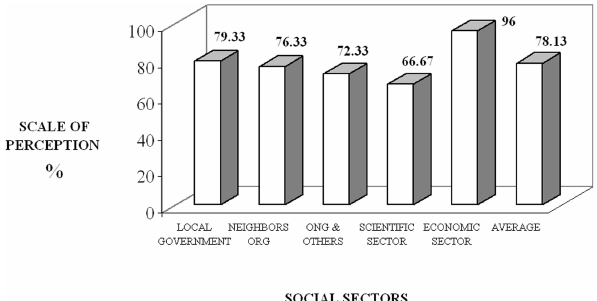
Fig. 14. Relevance of public involvement in flood management. Social sectors in Focus Group